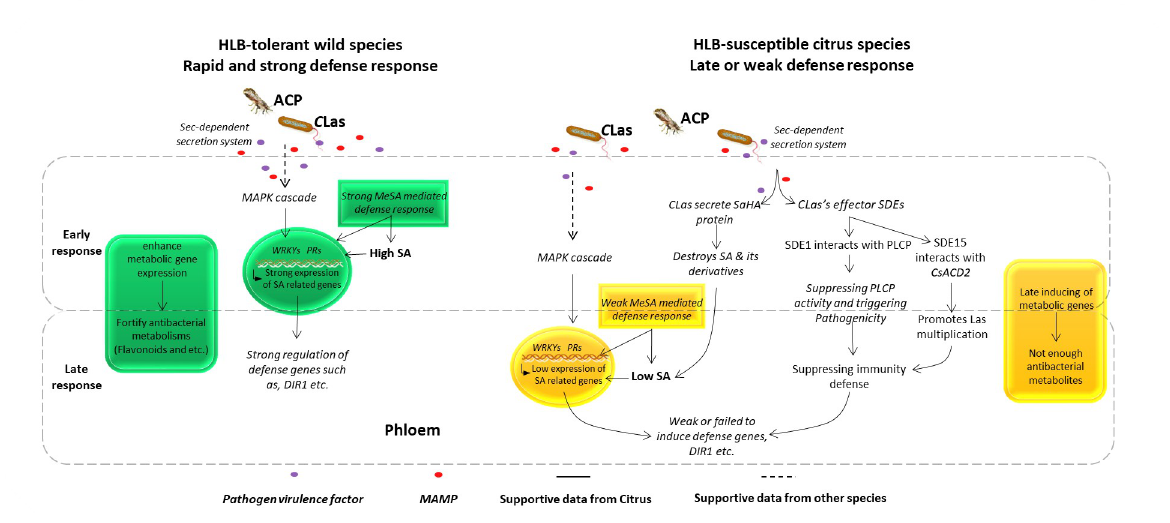
Fig 2. Sketch of the hypothetical pathway of HLB-tolerant and HLB-susceptible citrus species in response to C Las. In HLB-tolerant citrus species, first, C Las invasion causes cell signaling, which enhances the secondary metabolic genes [160] to biosynthesize antimicrobial compounds such as volatiles, fatty acids, amino acids, and some antibacterial compounds such as flavonol, flavone, and flavanone [124]; second, C Las may secrete PAMPs and pathogen virulence factors into the phloem to interfere with various targets [7] such as genes, proteins, and metabolites. In HLB-tolerant citrus, the MAPK [133] activates the downstream defense-related genes such as WRKY genes to trigger the PR reaction and strongly induce SA- mediated defense response [168], and the expression of DIR1 genes, NPR4, SA-related genes will be induced to contribute to the high HLB tolerance [143]. In HLB-susceptible citrus species, first, C Las infection affects the photosynthesis and primary metabolism, decreases starch degradation enzymes, increases the expression of starch biosynthetic genes (such as GBSS1 and glgC ), and induces PP2 gene, which triggers starch and callose accumulation and causes phloem plugging [118]. Disruption of primary metabolism causes delayed or reduced biosynthesis of secondary metabolites (antibacterial compounds such as flavonols), and susceptible citrus shows severe symptoms; second, the C Las secretes virulence factor proteins such as a functional enzyme SahA into citrus plant, destroying the host’s SA and its derivatives to suppress the host defense [116]. In addition, SDEs move into cells via the Sec-dependent secretion system; SDEs such as SDE1 interact with receptor protein PLCP and suppress its activity, which weakens the citrus plant defense response [107]. Moreover, the SDE15 interacts with citrus protein CsACD2 and suppresses the plant immunity and promotes C Las multiplication [110]. In this way, the C Las protein disrupts the normal metabolism and defense system of host cells by modifying the host cellular machinery to manipulate pathogenicity and to make the host environment favorable for C Las survival and progression. ACP, Asian citrus psyllid; HLB, Huanglongbing; MAPK, mitogen-activated protein kinase; PAMP, pathogen-associated molecular pattern; PLCP, papain-like cysteine protease; PR, pathogen-related; SA, salicylic acid; SahA, salicylate hydroxylase; SDE, Sec-delivered